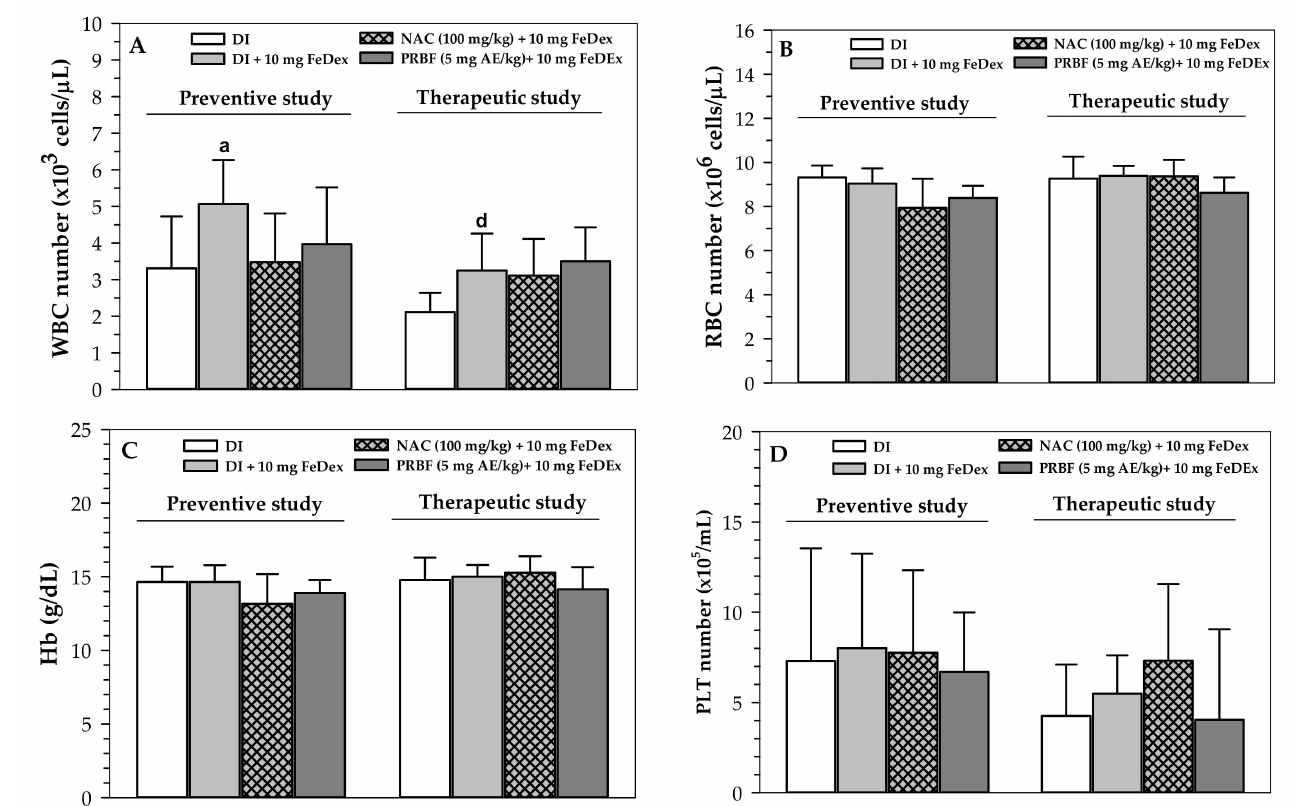
Figure 2. Hematological parameter levels in FeDex-loaded mice treated with DI, NAC and PRBF. In terms of a preventive effect, mice were treated with DI, NAC (100 mg/kg) and PRBF (5 mg AE/kg) for 14 d. This was followed by a single ip injection with 10 mg FeDex after the last oral dose was administered on day 14. In terms of a preventive effect, mice were then sacrificed; their heart blood was collected and their hematological parameter levels were determined. In term of a therapeutic effect, mice were ip injected with 10 mg FeDex together with DI, NAC (100 mg/kg) and PRBF (5 mg AE/kg) for 14 d. Mice were then sacrificed, their heart blood was collected and their hematological parameter levels were determined. Data are expressed as mean ± SD values ( n = 6). a p < 0.05 when compared with DI alone in the preventive study; d p < 0.05 when compared with DI alone in the therapeutic study. Abbreviations: AE = anthocyanin equivalent, PRBF = plasma-treated Riceberry™ rice flour, DI = deionized water, FeDex = iron dextran, Hb = hemoglobin ( C ), NAC = N -acetylcystein, PLT = platelets ( D ), RBC = red blood cells ( B ), WBC = white blood cells ( A ), SD = standard